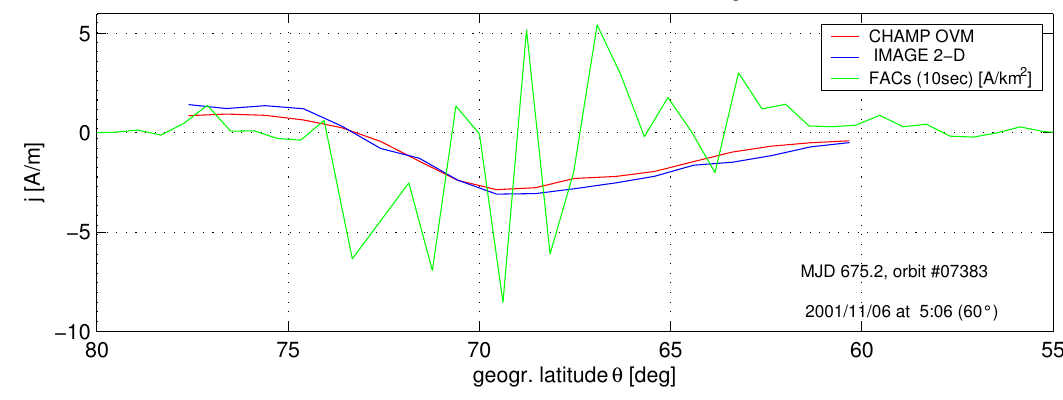
This signature suggests that the plasma convection in the magnetosphere is not entirely laminar but may form vortices at the interface between tailward and sunward (cid:3)ows. Con- sequently, we (cid:2)nd the most intense upward FACs not in the